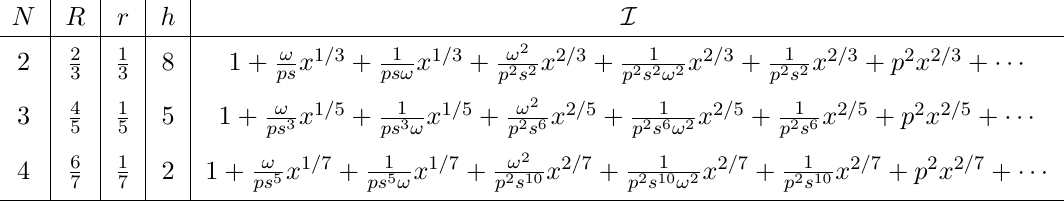
(cid:0) (cid:1) x h .